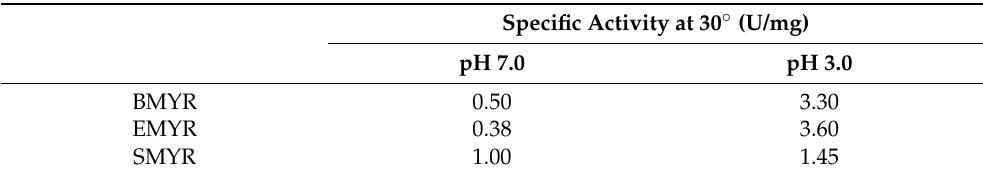
Table 6. Specific activity of myrosinases at optimum temperature and different pH